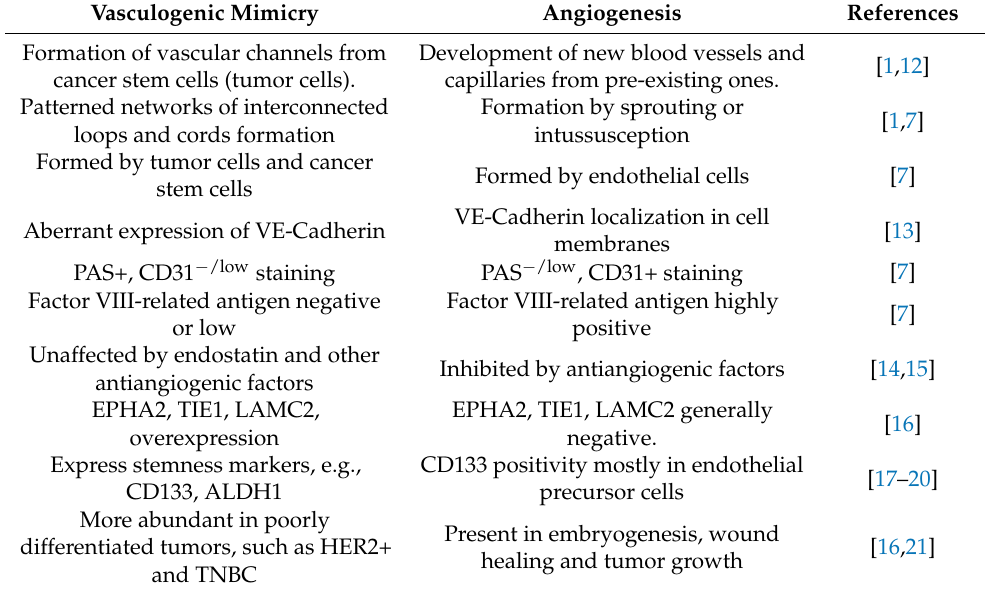
Table 1. Distinctive features/markers between vasculogenic mimicry and angiogenesis. Vasculogenic Mimicry